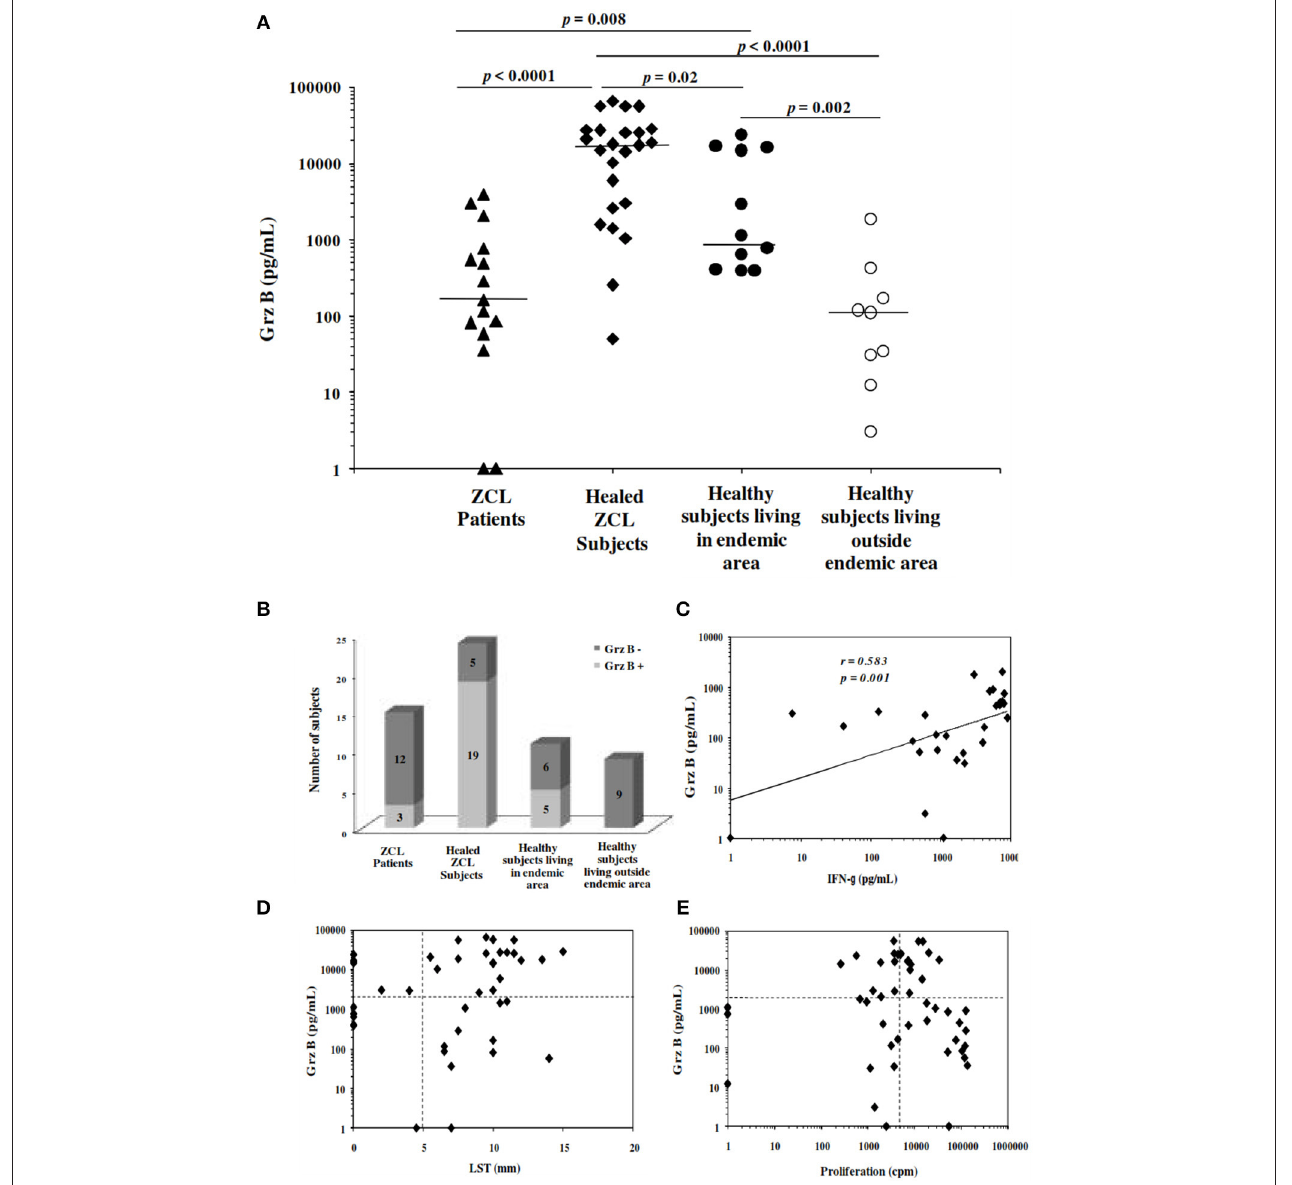
FIGURE 2 | Granzyme B levels induced in response to stimulation with Leishmania major . (A) Grz B is measured in culture supernatants of PBMCs incubated for 5 days with live promastigotes L. major at a ratio of 3 promastigotes per cell. We used PBMCs from patients with active ZCL, healed ZCL subjects or from healthy individuals living in endemic focus for transmission of L. major or outside these areas. Horizontal bars represent median values. (B) Histograms represent the number of subjects categorized in Grz B + and Grz B − , basing on the cut-off fixed at 2,000 pg/mL. (C) Association between Grz B and IFN- γ levels measured in the same supernatants (D,E) Association between Grz B levels and results of leishmanin skin test (LST), expressed as diameter of induration and the lymphoproliferative response to soluble Leishmania antigens (SLA), expressed as 1 cpm. Horizontal dashed lines indicate cut-off for Grz B level, LST and proliferation fixed at 2,000 pg/ml, 5mm and 5,000 cpm,